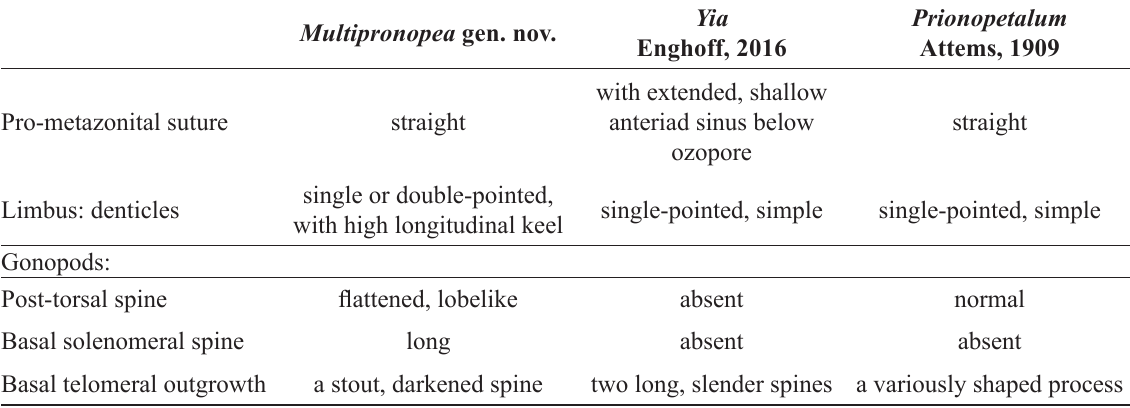
Table 3. Comparison of three odontopygid